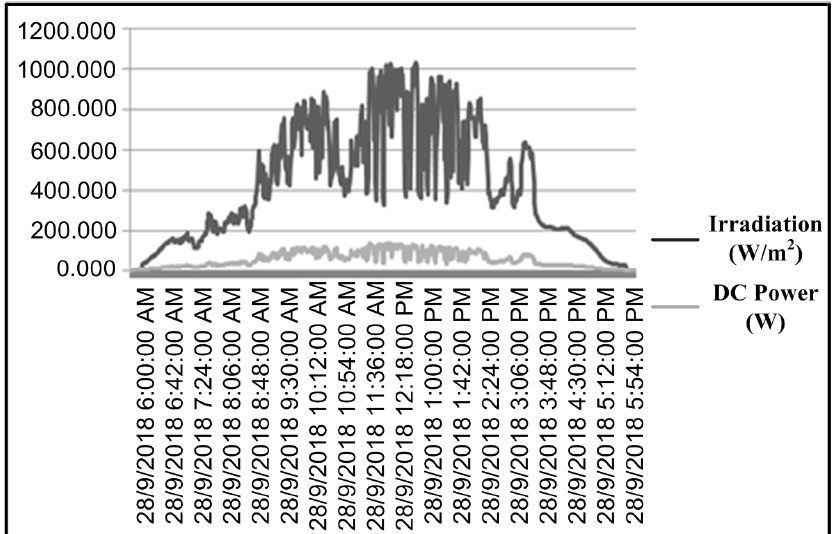
Figure 2. Irradiation and photovoltaic (PV) power for normal solar variability.